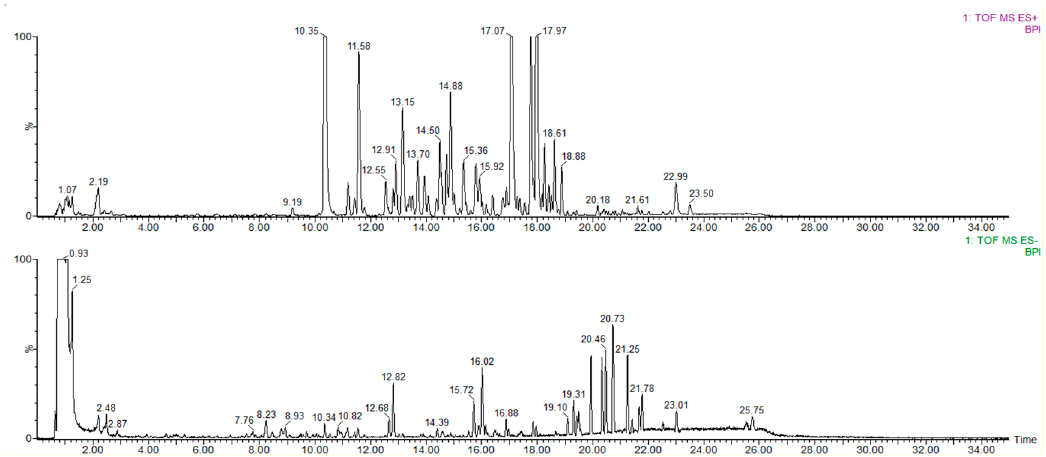
Figure 1. Typical total ion current (BPI) chromatograms of substances in the WWZ extract, under positive and negative ion modes.